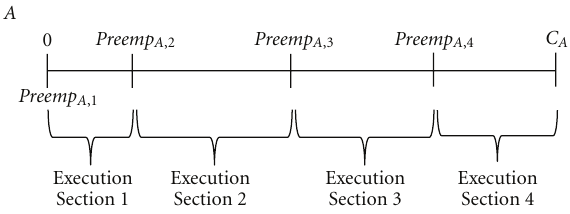
Figure 4: Predefined preemption points in Task A